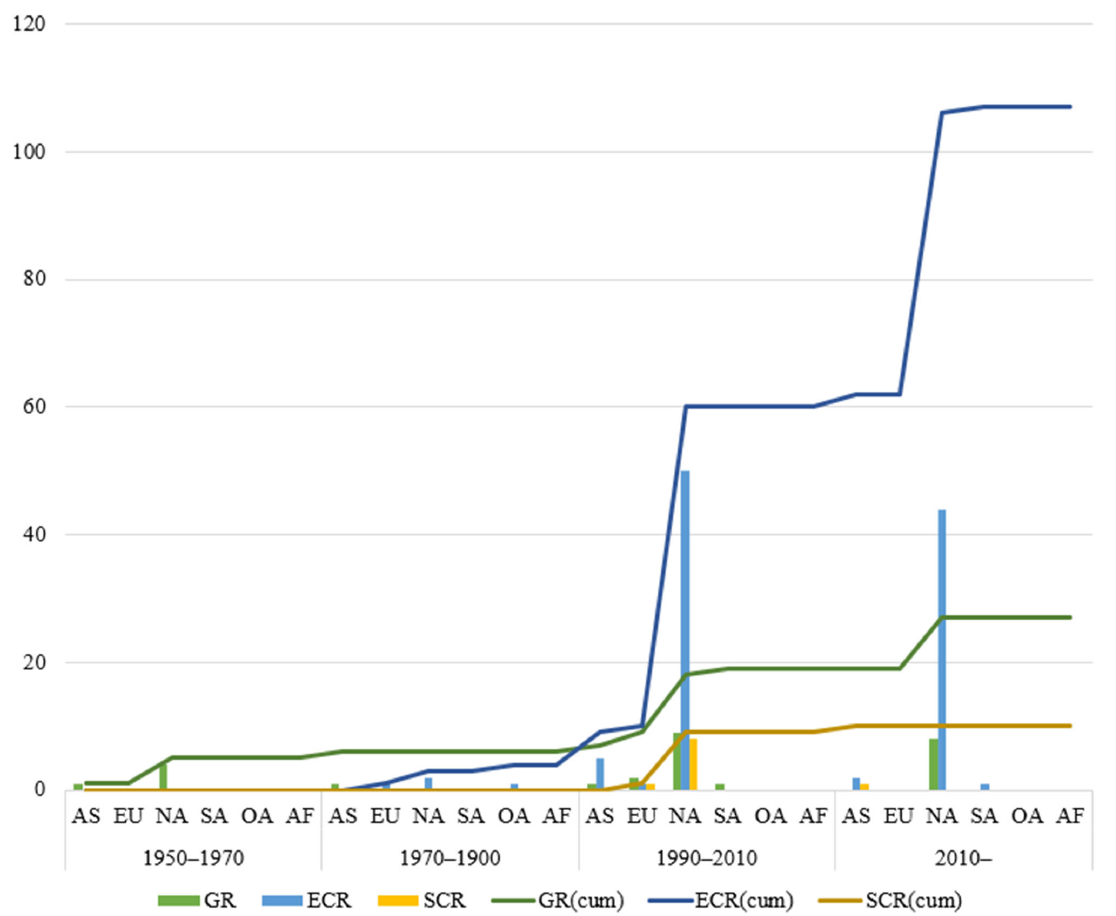
Figure 12. Applications of GR, ECR, SCR corresponding to the region and time Note: galvanized reinforcement (GR); epoxy coated reinforcement (ECR); stainless cladding reinforcement (SCR); Asia (AS); Europe (EU); North America (NA); South America (SA); Oceania (OA); Africa (AF).